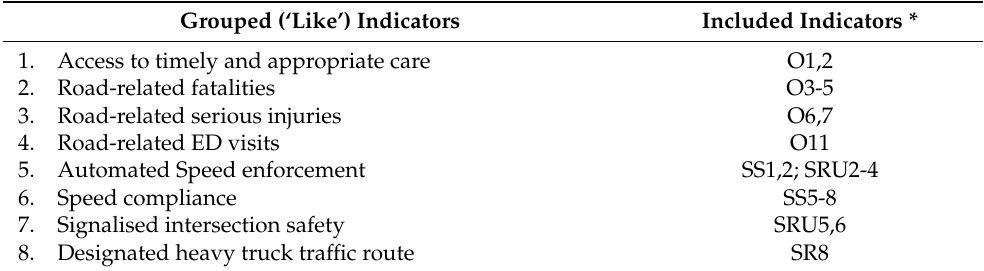
Table 2. Final list of grouped (‘like’) injury indicators (23 Road Safety, 8 Seniors Falls, and 13 All-Injury). Grouped (‘Like’) Indicators Included Indicators